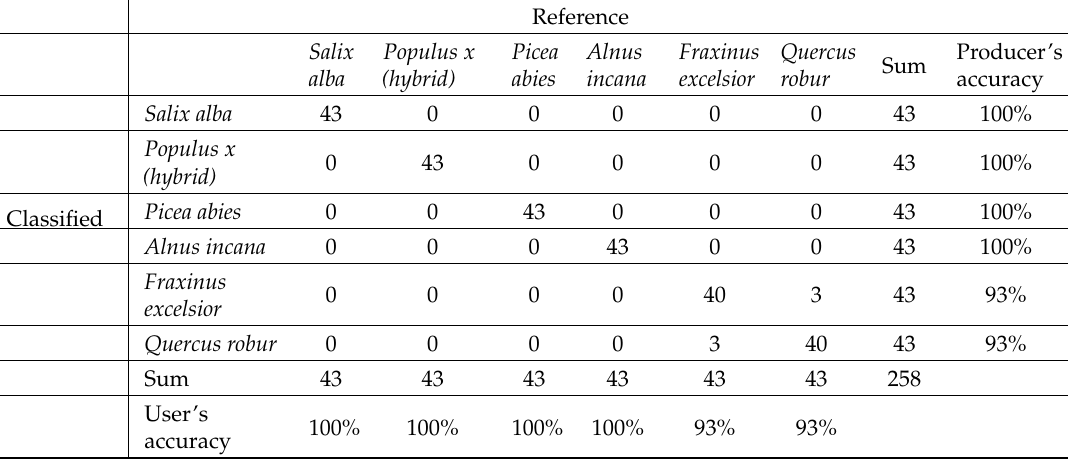
Table A5. The accuracy assessment using the ICA data cube (with 27 components) as an input to the RF